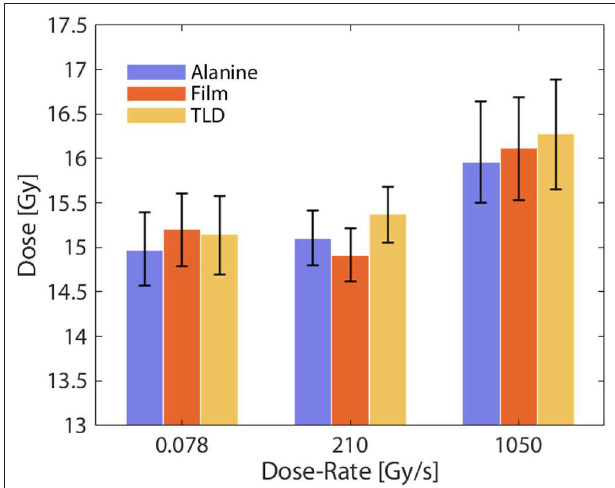
FIGURE 7 | Measured absorbed dose under different dose-rate conditions for alanine, film, and TLD. All detectors were found to agree within 3% at conventional and FLASH dose-rates, indicating excellent dose-rate independence. Data adapted from Jorge et al. [